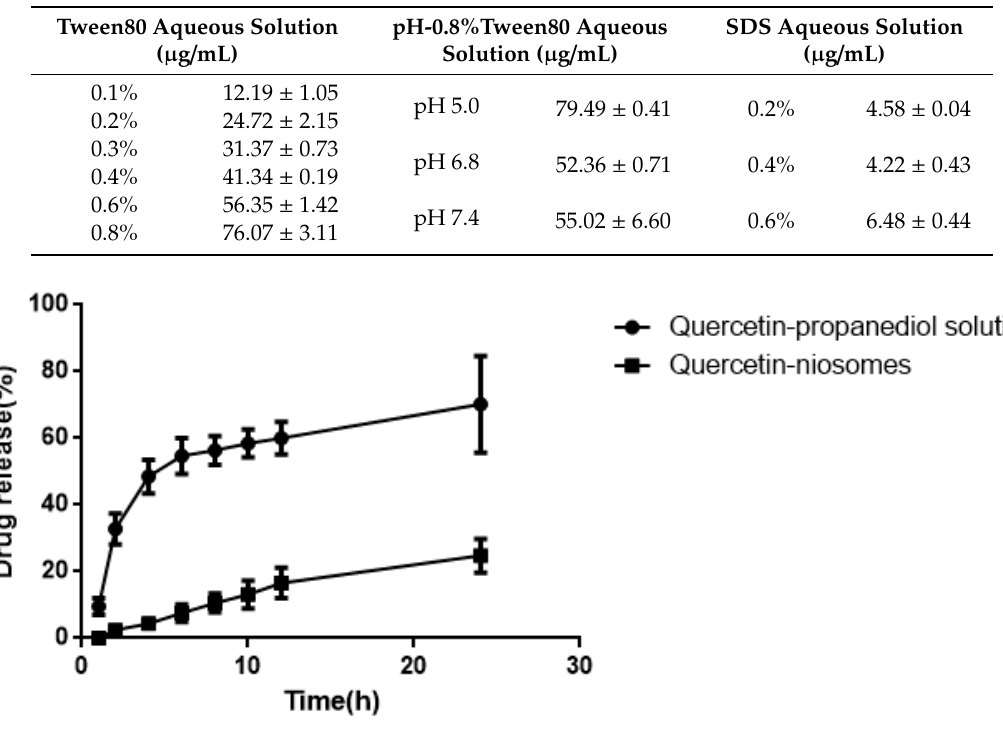
Table 5. Solubilities of Quercetin in di ff erent release medium.